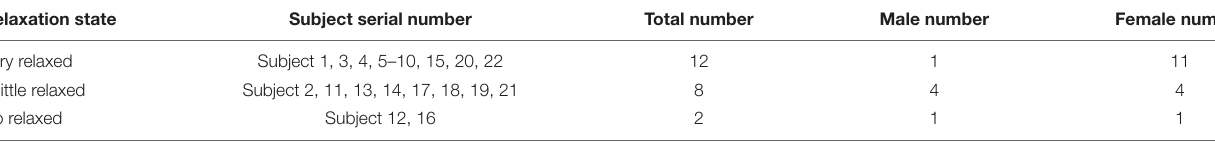
FIGURE 9 | Data collection settings for patients with depression. TABLE 8 | Relaxation model training MAE results.